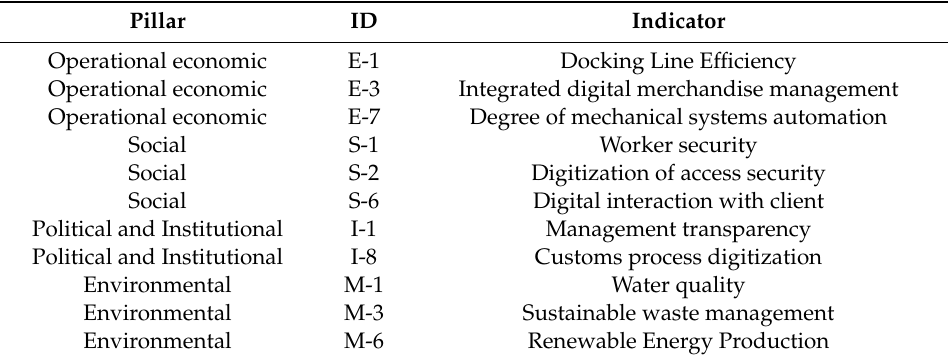
Table 4. Indicators most highly rated of each